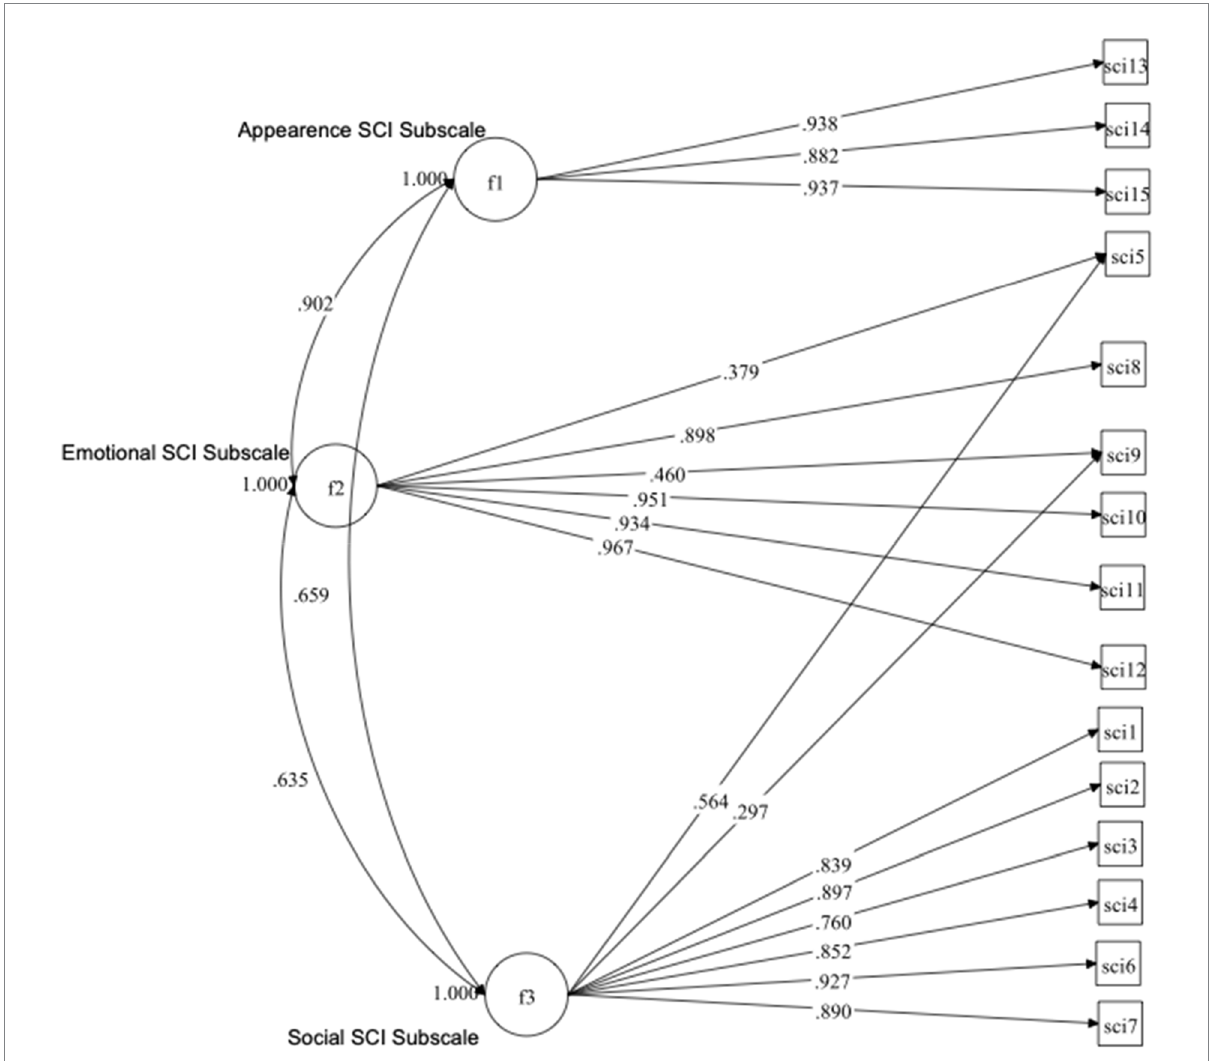
FIGURE 1 Graphical representation of the refined model (Model-7), with standardized values.